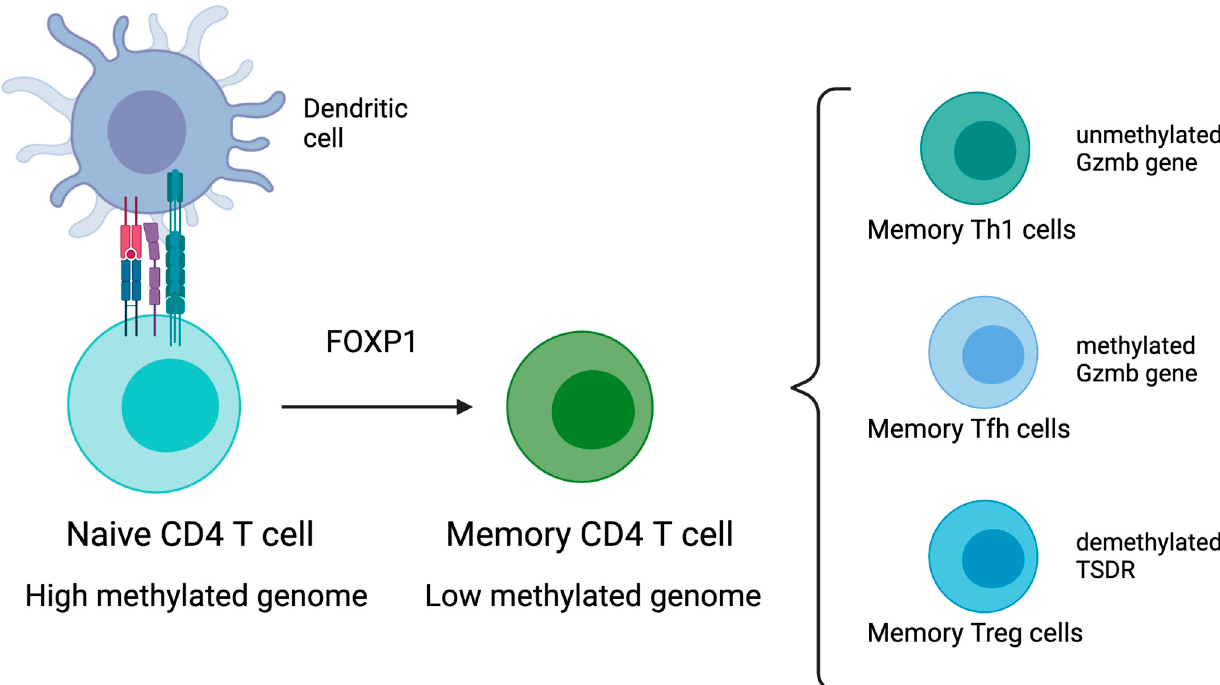
Figure 1. DNA methylation and memory CD4 T cell: memory CD4 T cells are generated following activation of naïve T cell by dendritic cell presenting peptide on major histocompatibility complex (MHC) molecules. FOXP1 is a transcriptional factor that controls memory differentiation and is regulated by DNA methylation. There is a progressive loss of DNA methylation during memory differentiation. DNA methylation of Gzmb gene can be used as a marker to distinguish memory CD4 Th1 from Tfh. The expression of Foxp3 in memory Treg is controlled by DNA methylation at TSDR (Treg cell-specific demethylation region).